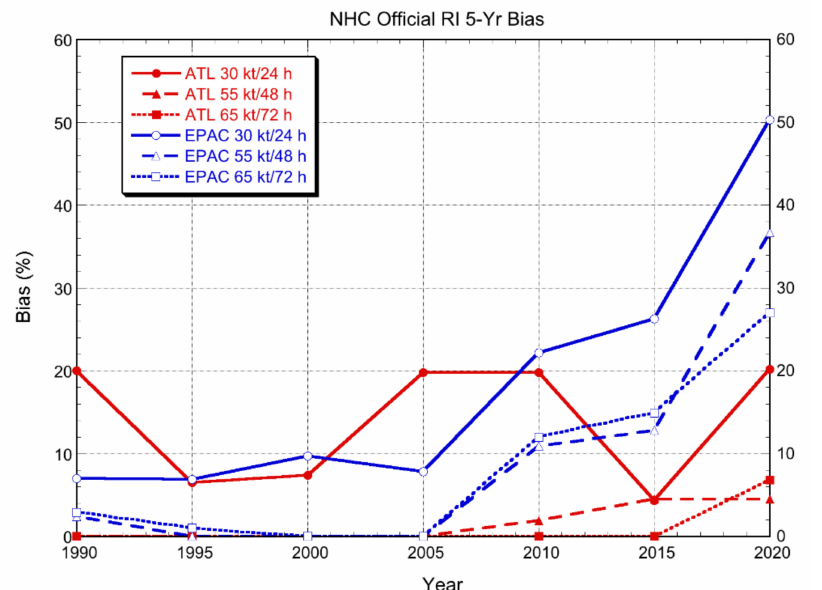
Figure 11. Bias (%) of the NHC official forecasts from 1986–2020 for the Atlantic (red) and eastern North Pacific (blue) basins for the three RI thresholds. Each point on the diagram represents a five-year sample of forecasts ending at the year